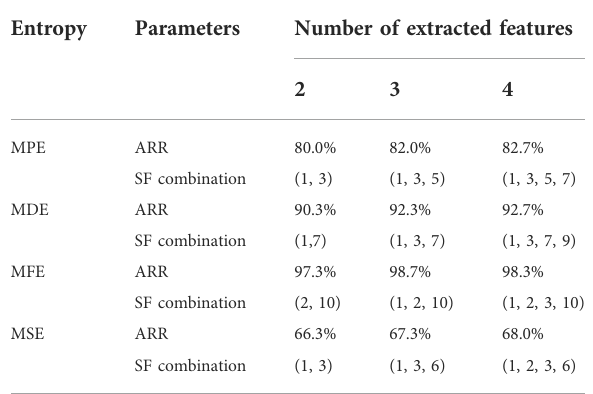
TABLE 3 Highest ARR of four types of entropies for six ANs under different number of features.